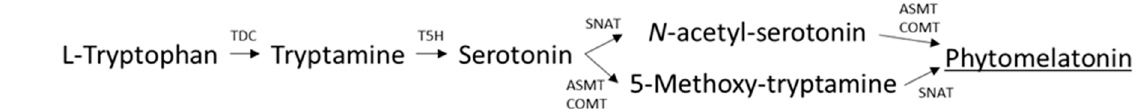
Figure 1. Simple scheme of phytomelatonin biosynthesis pathway in plants. The steps are catalyzed by the enzymes TDC, T5H, SNAT and COMT.